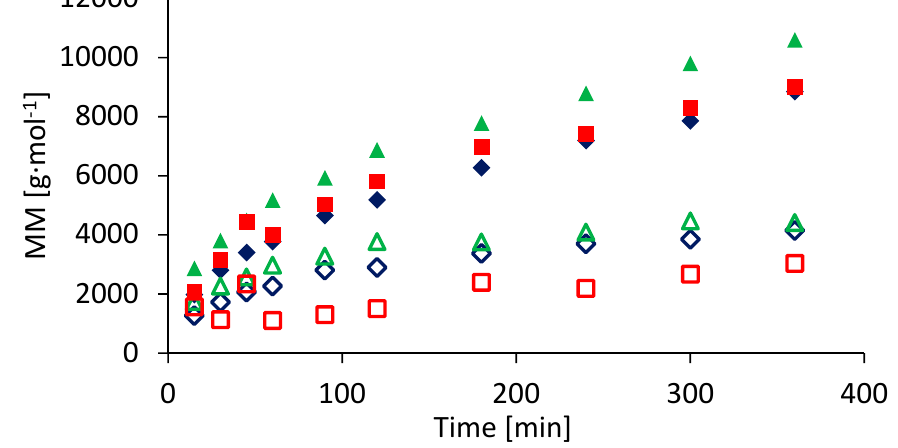
Figure 3. Evolution of number- (open symbols) and weight- (filled symbols) average polymer molar masses for BA/HEA copolymer produced via semi-batch polymerization in BPi with 12.5 ( ♦ ), 25 ( ▲ ) and 40 wt % ( ■ ) HEA in the feed.